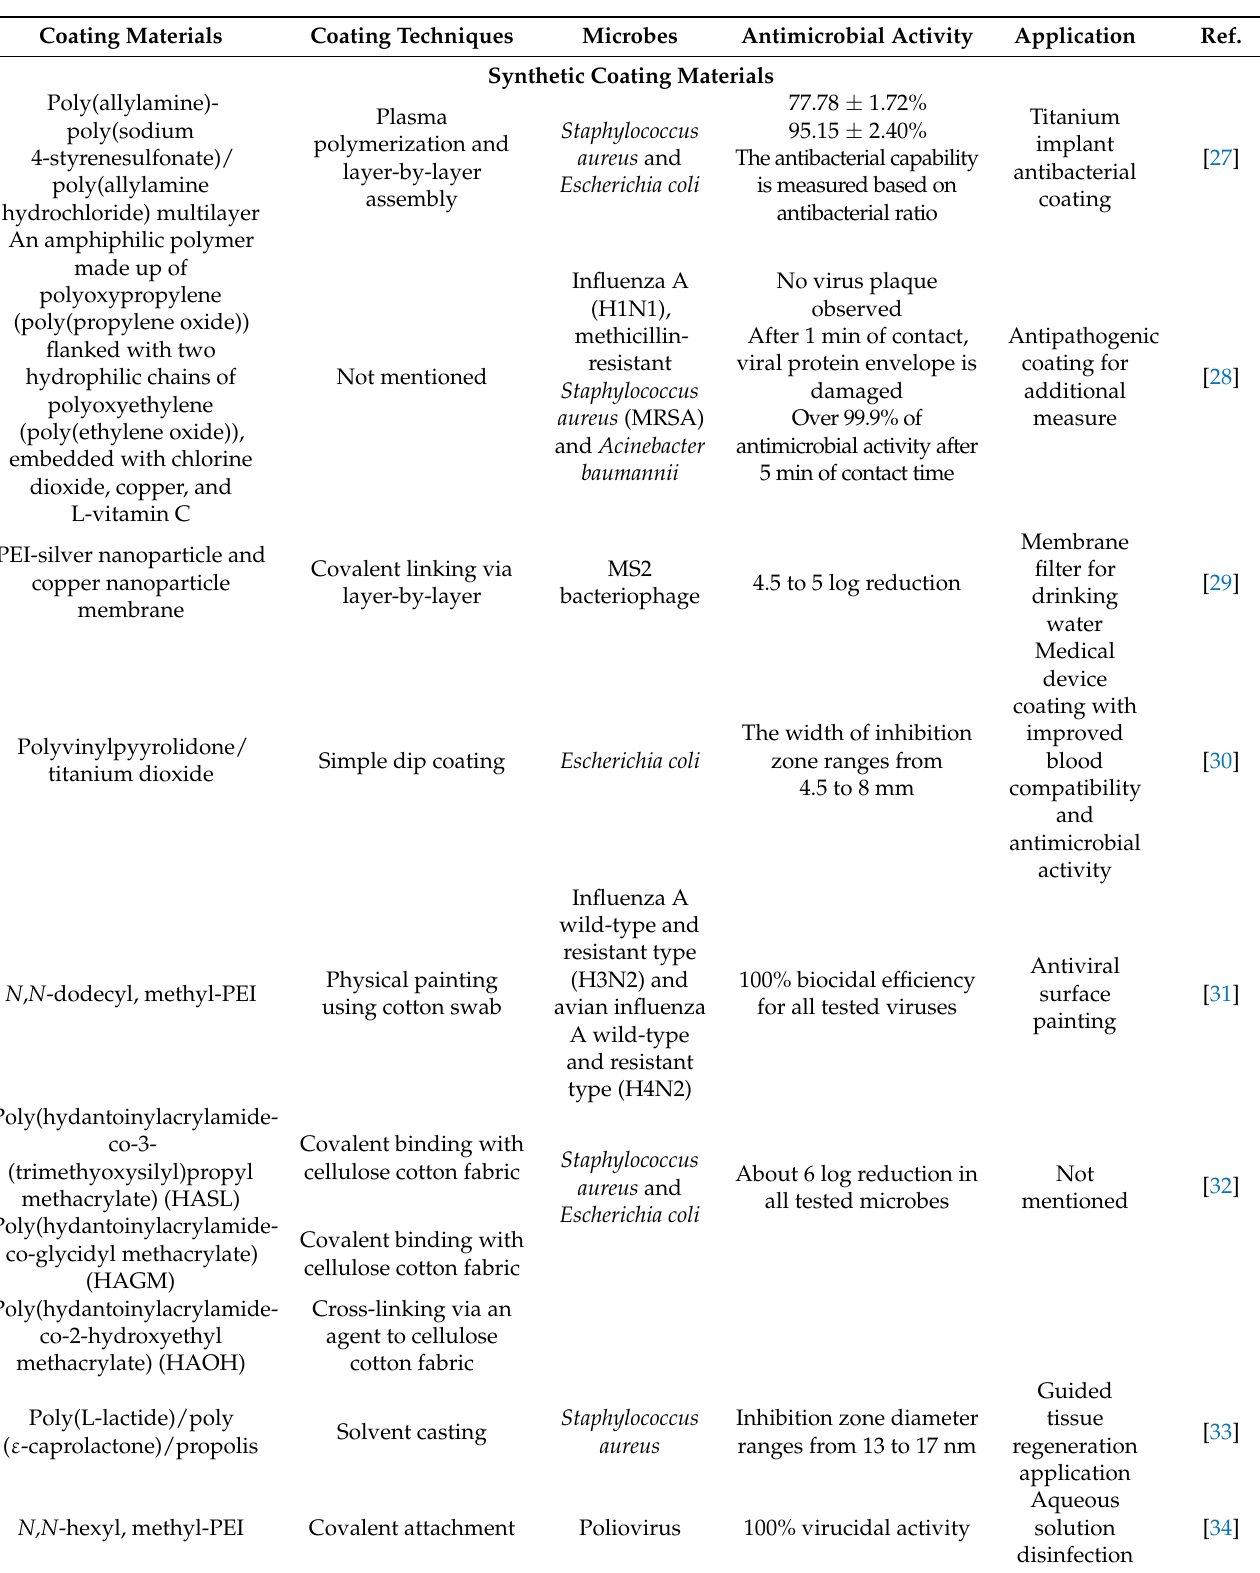
Table 1. Application of antimicrobial polymer coating with their antimicrobial activity